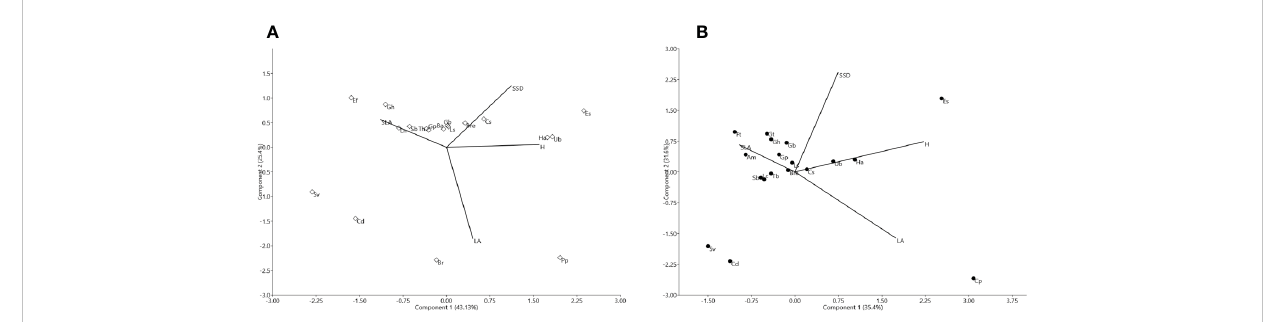
FIGURE 1 (A) . Biplot spatial diagram for the taxa of the Halimium shrubland (HS). The solid black dots are the studied taxa, identi fi ed with abbreviations indicated in Supplementary Material 2 Table S1. Traits are represented using abbreviations as follows: H: plant height (cm), SLA: speci fi c leaf area (mm 2 /mg), LA: leaf area (mm 2 ), and SSD: stem speci fi c density (mg/mm³). (B) . Biplot spatial diagram of the taxa of the Cistus shrubland (CS). Solid black dots are the taxa, identi fi ed with abbreviations indicated in Supplementary Material 2 Table S1. Traits are represented using abbreviations